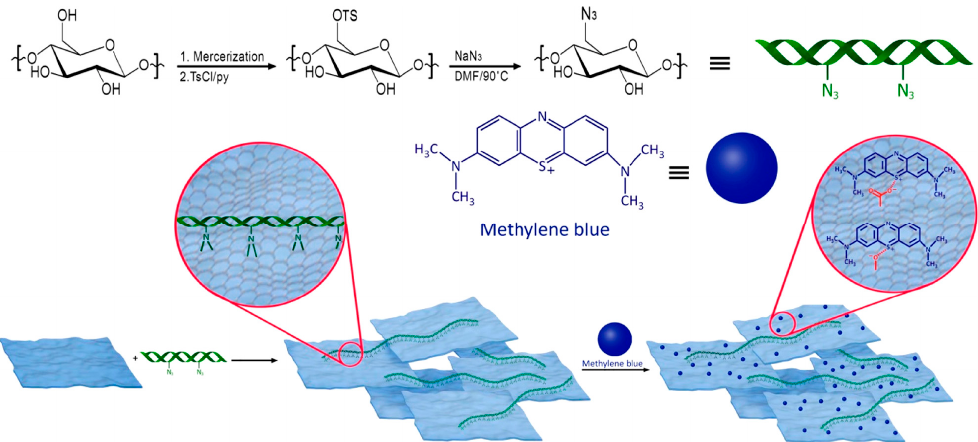
Figure 9. Schematic representation of the production procedure, as well as the exhibition of the carboxylate and phenoxide adsorption, GO sites of the hybrids towards methylene blue. Reproduced with permission from Reference [159]. Copyright ©2019, American Chemical Society. Nanomaterials 2020 , 10 , x FOR PEER REVIEW